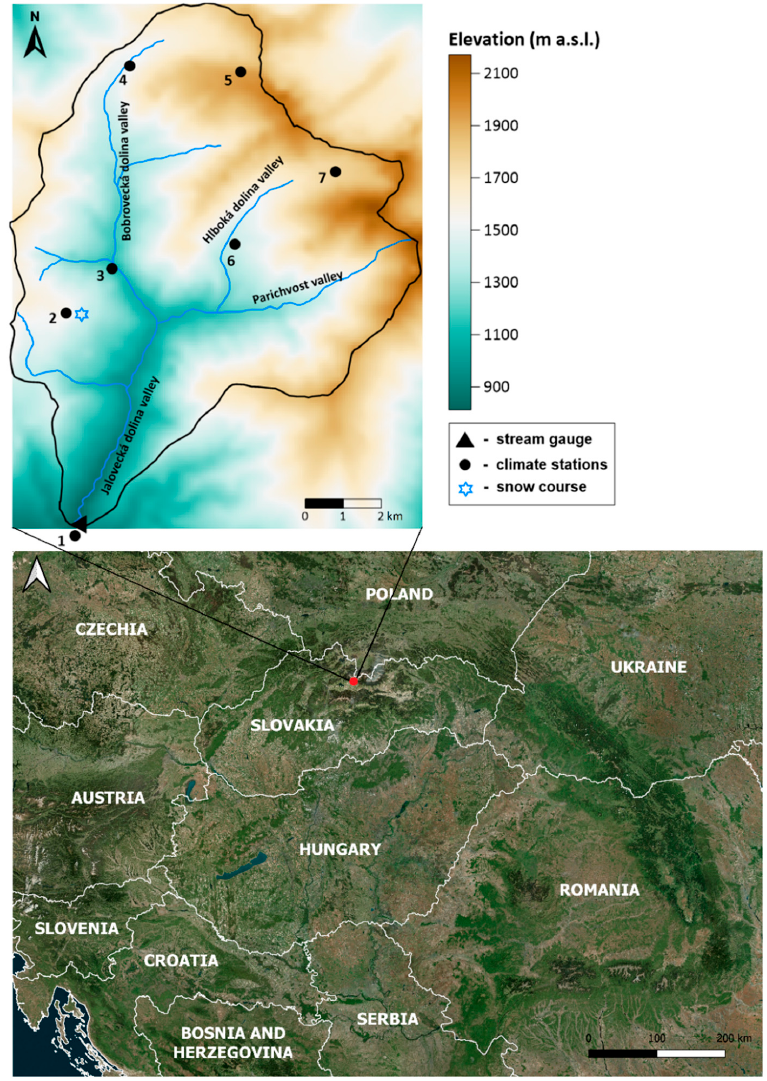
Figure 1. Map of Europe ( bottom )—the red point indicates the location of the study catchment within Slovakia. The topography of the Jalovecký Creek catchment ( top )—the black triangle indicates stream gauge; the black circles are climate stations providing the air temperature (numbers 1, 2 and 5) and precipitation data (numbers 1–7); the blue star represents site with snow water equivalent